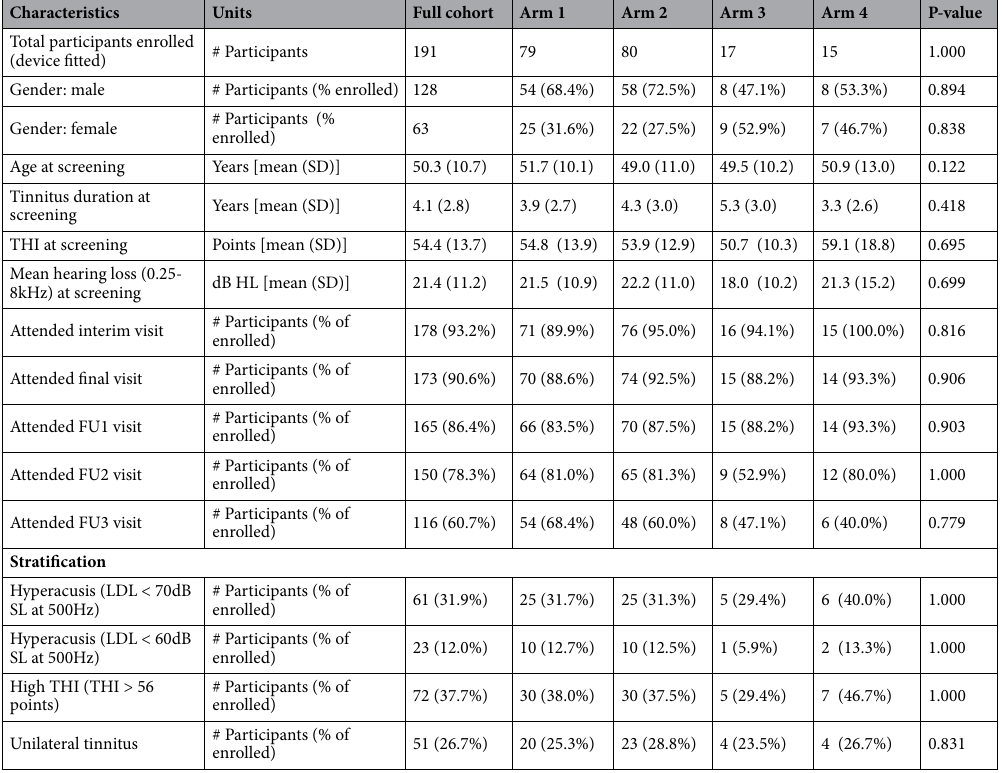
Table 1. Characteristics of enrolled participants in each arm with key numbers for each visit. dB HL, decibel hearing level; dB SL, decibel sensation level (equals dB HL minus hearing threshold level of sound stimulus); FU, follow-up; LDL, loudness discomfort level. A description of stratification categories is provided in the Methods. P-values were calculated for comparing arm 1 and arm 2 (i.e., arms used for primary endpoint analyses) using Fisher’s exact test for count variables or a linear regression for continuous variables. Participants were stratified into different arms based on hyperacusis level, THI severity and presence of a unilateral